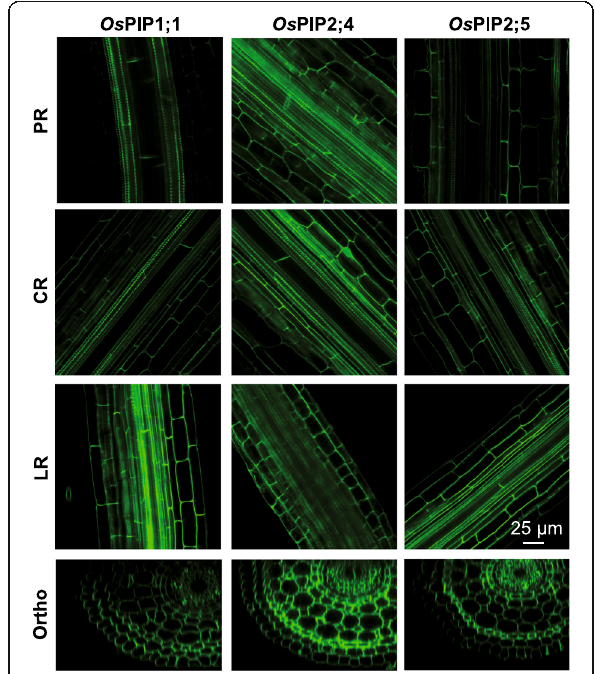
Fig. 3 In depth imaging of Os PIPs in rice root. ClearSee technique was applied prior to observation of Os PIP-GFP labelling in deep root tissues by multiphoton excitation microscopy. Root types: RR, radicle root; CR, crown root; LR, lateral root. Ortho stands for orthogonal section after reconstitution of Z-stack